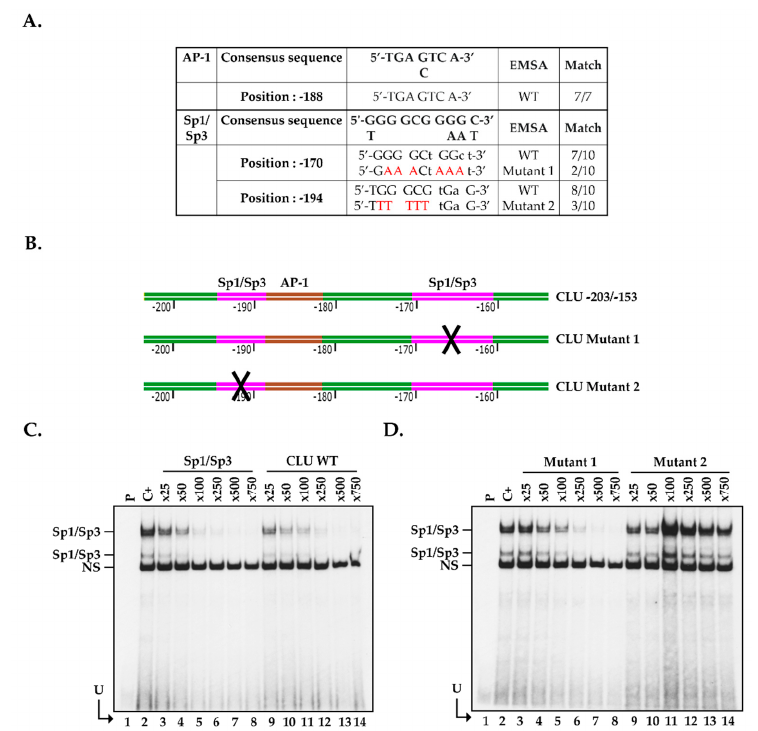
Figure 5. Sp1/Sp3 binding sites in the -203/-153 CLU promoter segment. ( A ) DNA sequence of the AP-1 and Sp1/Sp3 target sites from the CLU promoter identified at position -170, -188 and -194, respectively, aligned with their corresponding prototypical sequence. The nucleotides preserved between the CLU TF sites and their consensus sequences are shown in capital letters along with those selected for site-directed mutation (in red). ( B ) Schematic representation of the -203/-153 CLU promoter segment used in EMSA, and its derivatives that bear mutations into either the -170 (CLU Mutant 1) or the -194 (CLU Mutant 2) Sp1 site (the mutated site is indicated by an ‘X’). ( C ) Nuclear proteins (15 μ g) from control hCECs (Epi 70x) were incubated with the Sp1/Sp3-labeled probe bearing the consensus sequence for the Sp1/Sp3 TFs either alone (C+) or in the presence of increasing molar excesses (25 to 750-fold) of unlabeled CLU-203/-153, or of competitors bearing the target site for Sp1/Sp3 and run at 110V for 6.5 h. P: labeled probe without added proteins, U: free probe. ( D ) Same as in panel ( C ), except that the Sp1/Sp3-labeled probe was incubated either alone (C+) or in the presence of the unlabeled CLU Mutant 1 or CLU Mutant 2 oligomers.